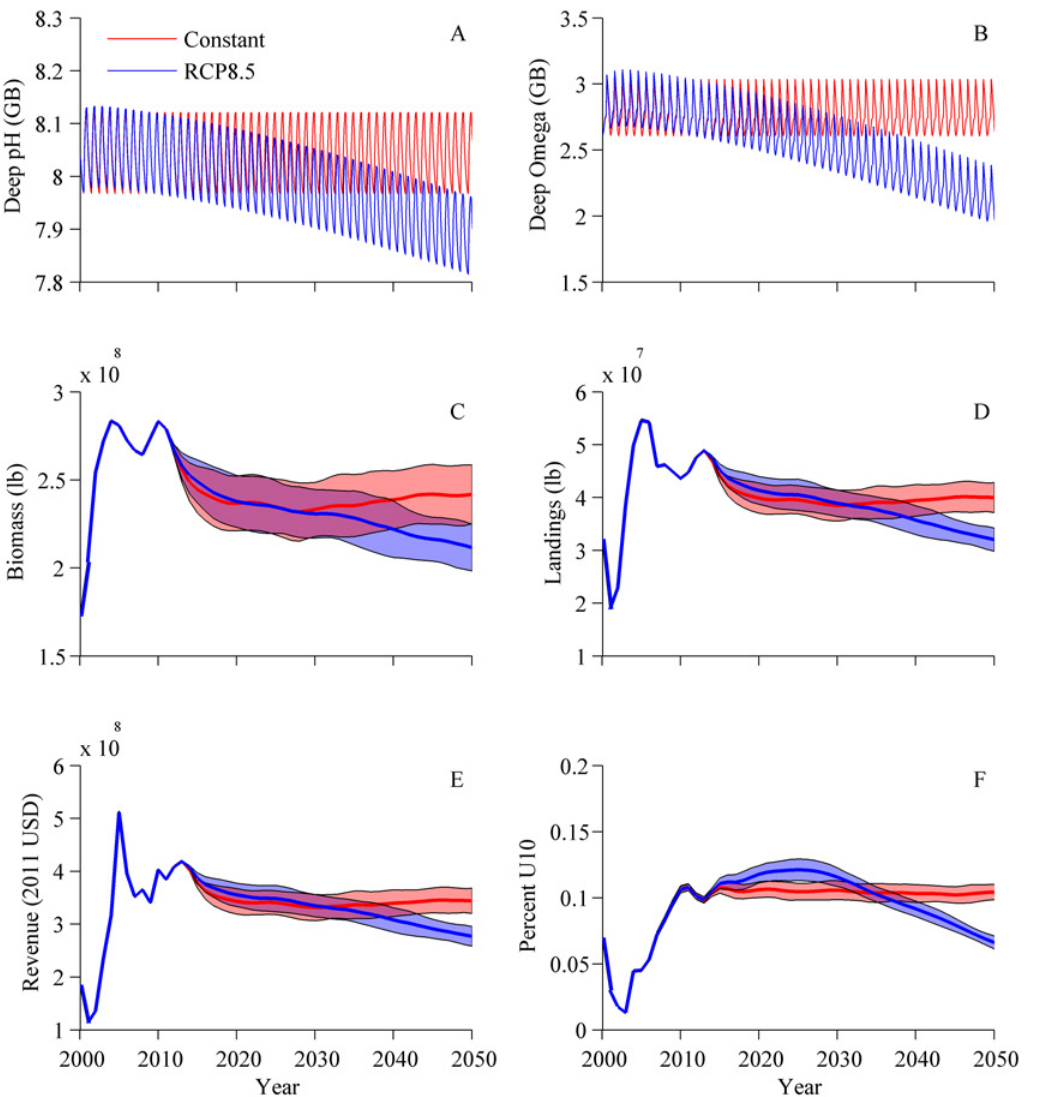
Fig 10. Mean ± SD (n = 100) model forecasts out to 2050 using CO 2 forcing from RCP 8.5 and 1.4°C SST warming (blue) and forecasts with constant 2008 CO 2 concentration and temperature (red). Deep box (A) pH and (B) calcite saturation state from Georges Bank, (C) landings, (D) total spawning stock biomass (scallops > 40mm shell height), (E) revenue (2011 USD), and (F) fractional landings in category U10 (meat weight 10 and under